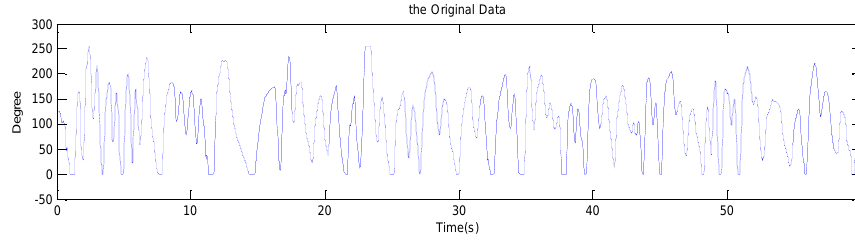
Figure 17. Abnormal breathing pattern from digital respiratory sensor.